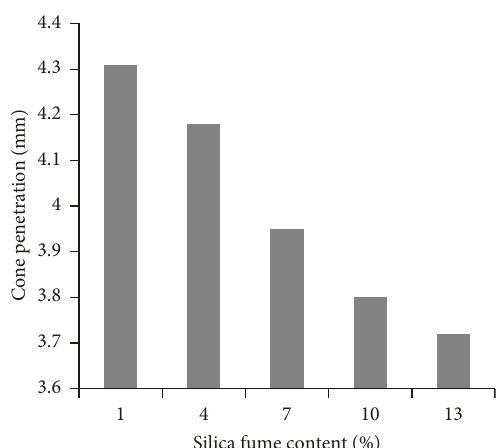
Figure 3: Influence of the content of silica fume on the cone